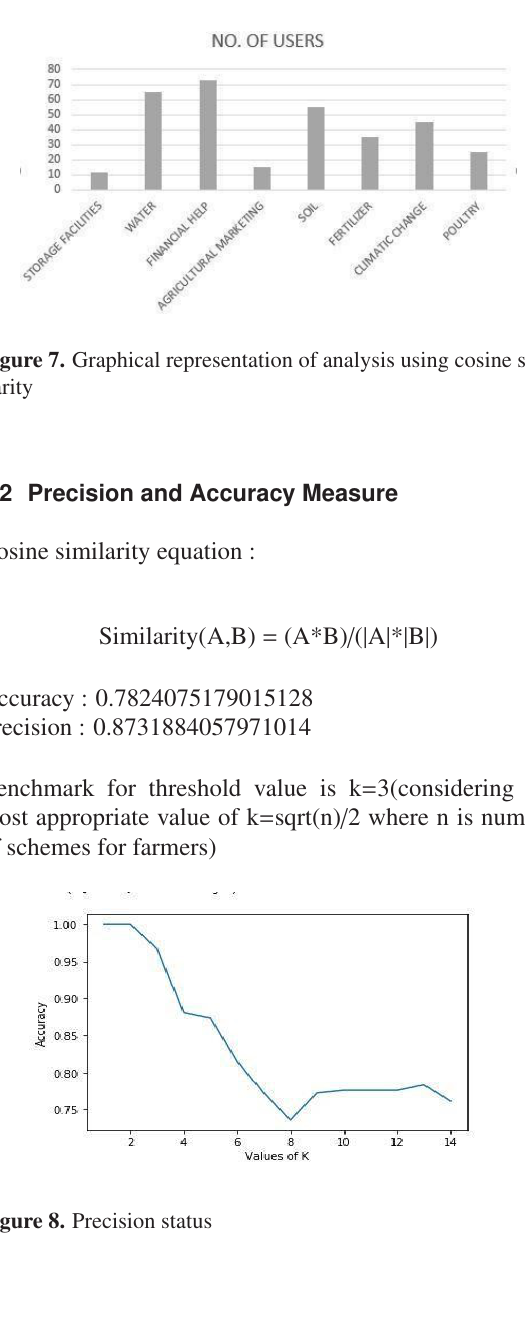
Figure 8. Precision